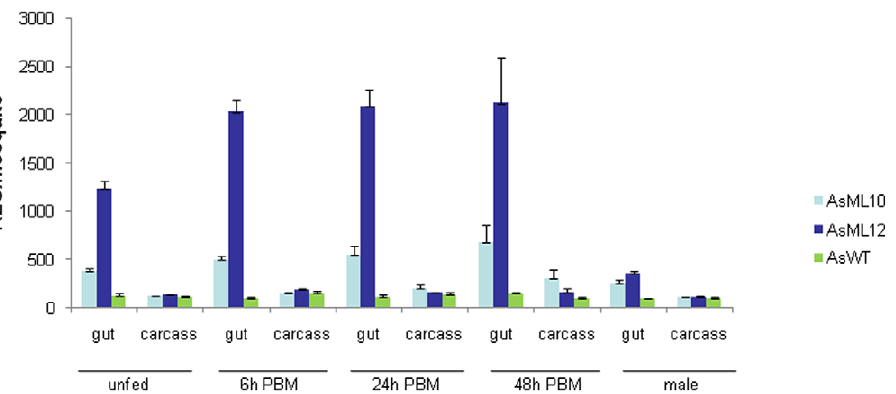
Figure 2. Blood meal inducibility and female predominance of transgenic luciferase activity driven by the Antryp1 promoter. Comparison of luciferase activity in the transgenic lines AsML10 and AsML12 against wild type A.stephensi host (AsWT). Guts and carcasses from unfed females, females 6 h, 24 h, and 48 h post blood feeding and males were analysed individually. Bars show the mean of 20 samples for each condition. Error bars indicate the standard error of the mean. reporter construct was included in the piggyBac transformation vector pPB-G12EGFP, containing also the 3xP3-DsRed marker gene (Figure 1c)[23]. Transformation experiments with pPBg12EGFP yielded 7 different founder families, representing a minimum transformation efficiency of , 13% (Table S2). As has been noted in other reports of piggyBac transformations[24,25,26,27], transforma- tion events were characterised by multiple insertions (Figure 1d, which represents the transgenic lines at generation 5).